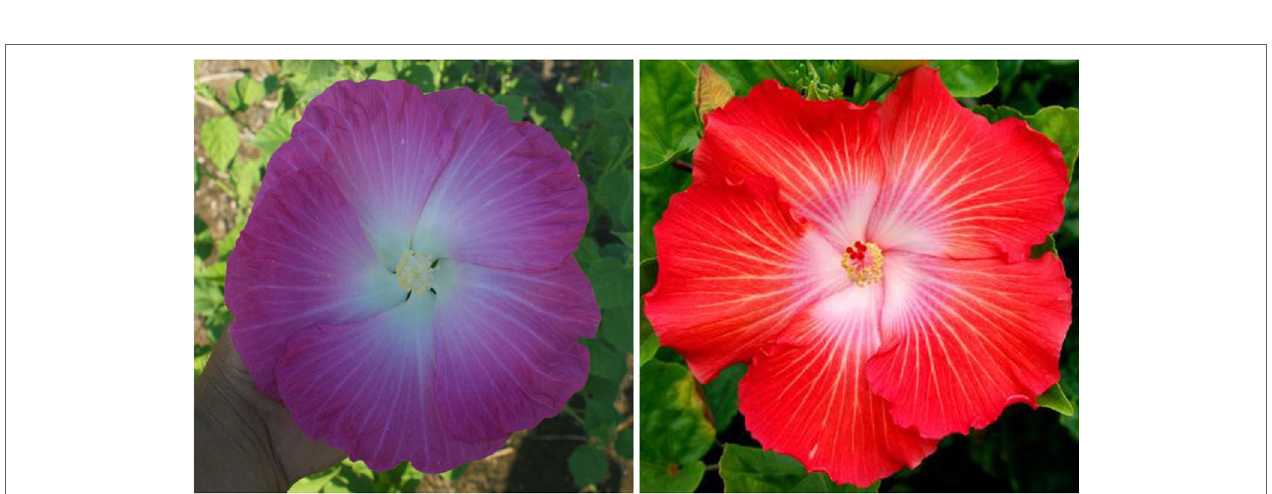
FIGURe 2 | Flower color and shape of H. x moscheutos hybrid “TAMUS-4406” (left) and H. rosa-sinensis “Radiant” (right). Photo credits: Dariusz P. Malinowski (“TAMUS-4406”) and Cindy Black (“Radiant”), Hidden Valley Hibiscus. Used with permission.